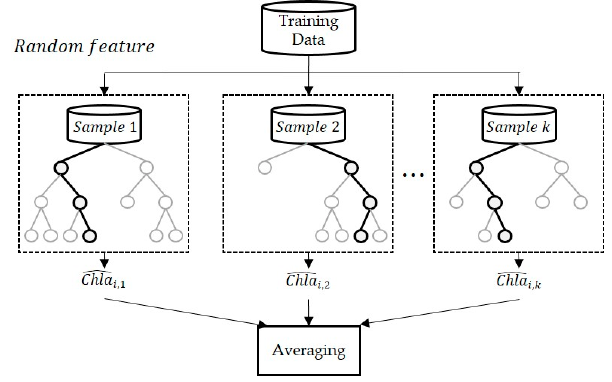
Figure 5. Schematic of the random forest method.